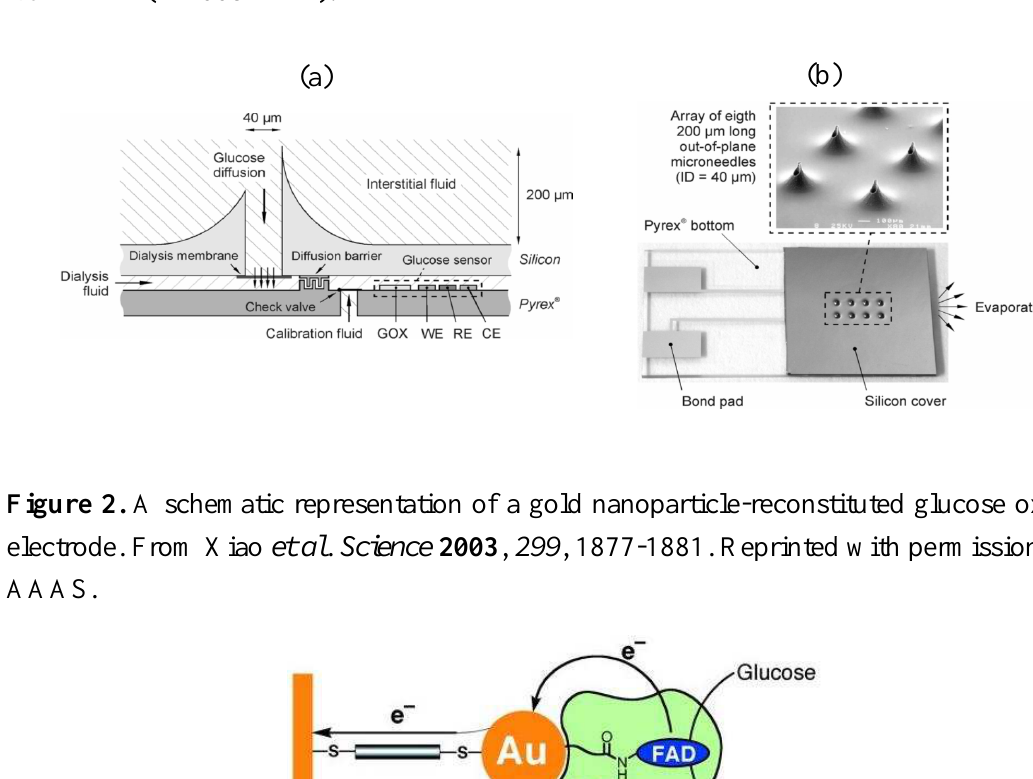
Figure 1. (a) Schematic diagram and (b) photographs of a microneedle-based glucose monitor. From Zimmermann et al ., Transducer ’03, The 12 th International Conference on Solid State Sensors, Actuators and Microsystems , pp. 99-102. Reprinted with permission from IEEE ( (cid:211) 2003 IEEE).